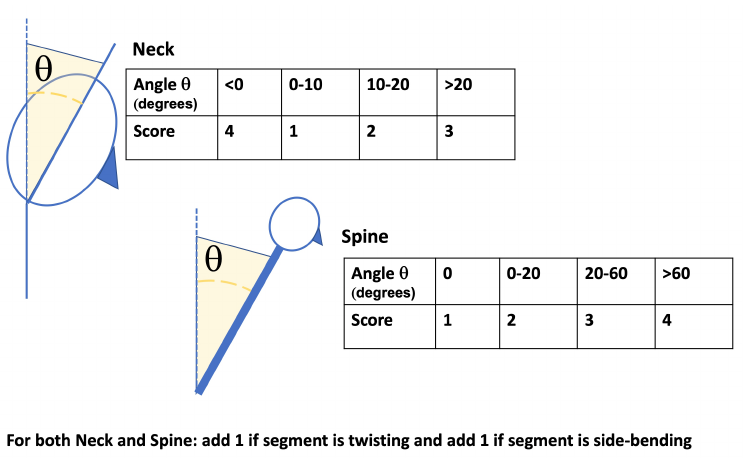
Figure 1. Representation of the posture evaluation of neck and trunk reported in section “B” of the RULA method. Figure modified from the work of McAtamney and Corlett